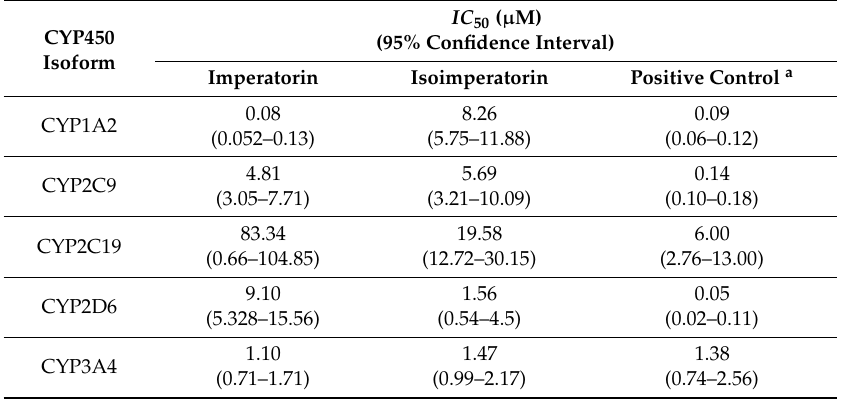
Table 3. IC 50 of imperatorin and isoimperatorin on CYP450s ( n =